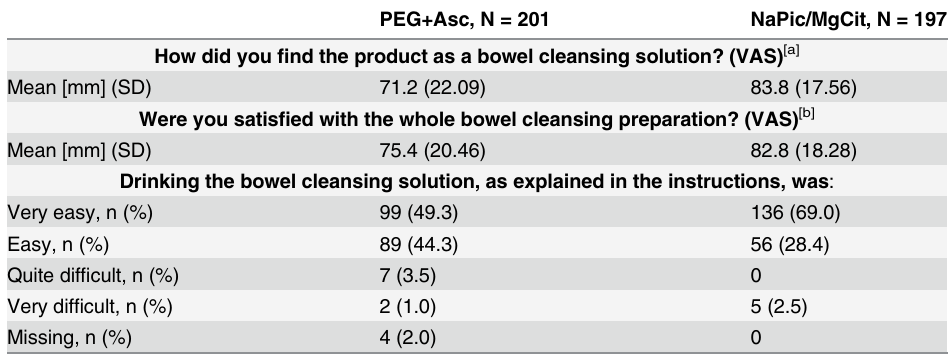
Table 4. Acceptability Assessment (Safety